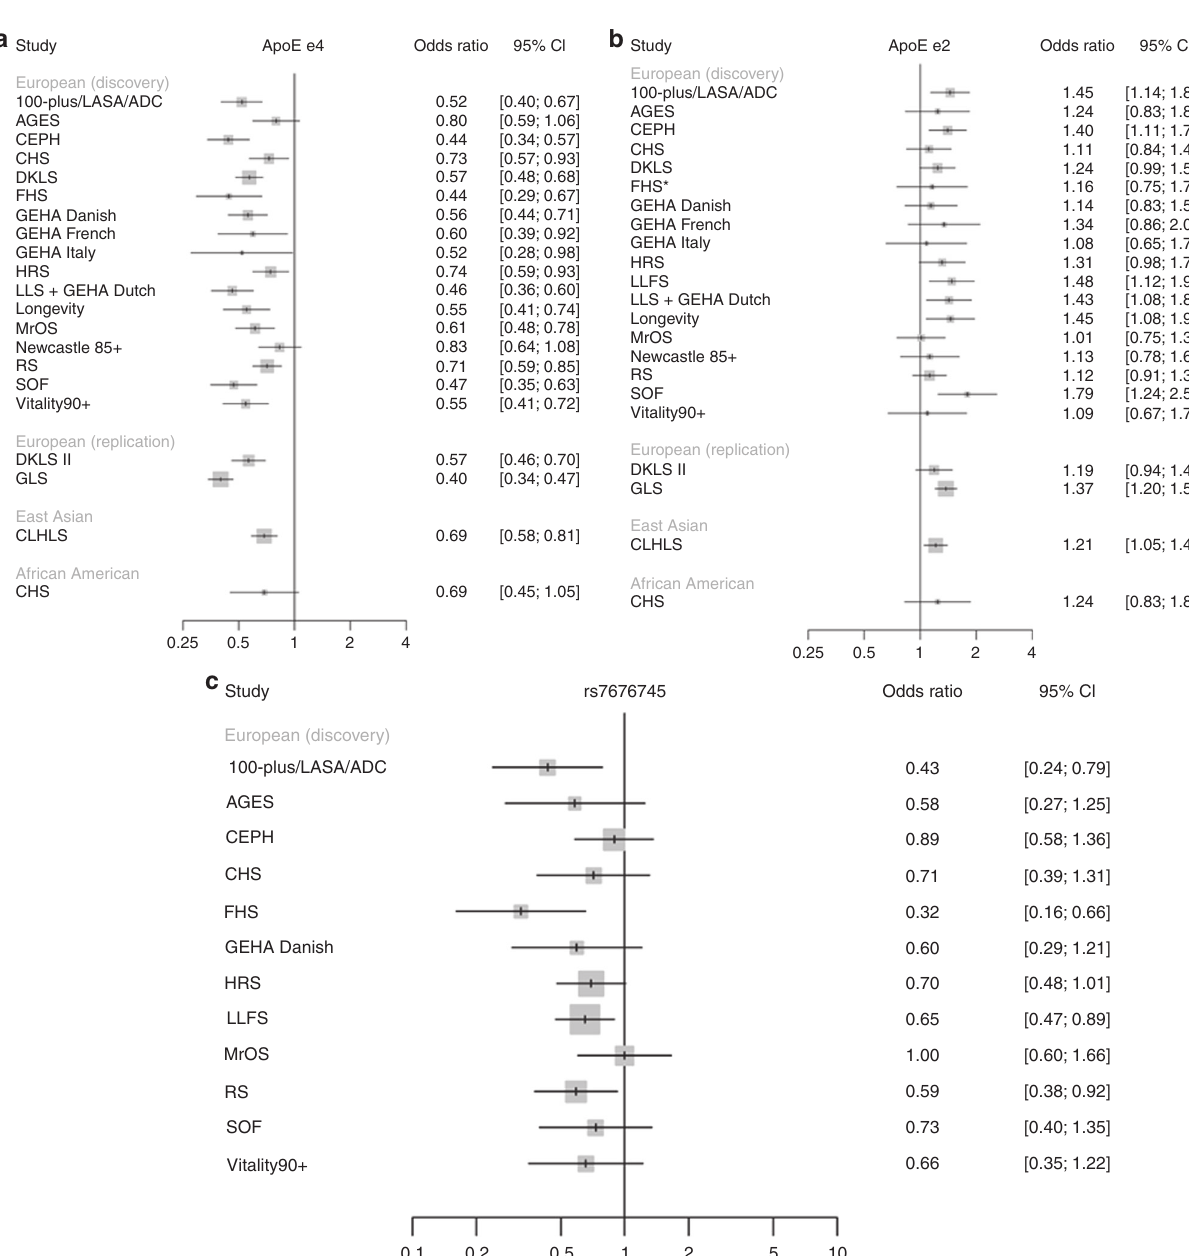
Fig. 2 Study-speci fi c results for the genetic variants in APOE and GPR78 . Forest plots for the ApoE ε 4 ( a ) and ε 2 ( b ) variants and rs7676745 ( c ) based on the results from the 90th percentile versus all controls analysis. The size of the boxes represents the sample size of the cohort. We had no data available for ApoE ε 4 in LLFS and for rs7676745 in DKLS, GEHA Italy, GEHA Danish, LLS (combined with GEHA Dutch), Longevity, and Newcastle 85 + . The data for ApoE ε 2 in FHS was based on imputation using the Haplotype Reference Consortium reference panel due to the low-imputation quality of this variant when using the 1000 Genomes reference